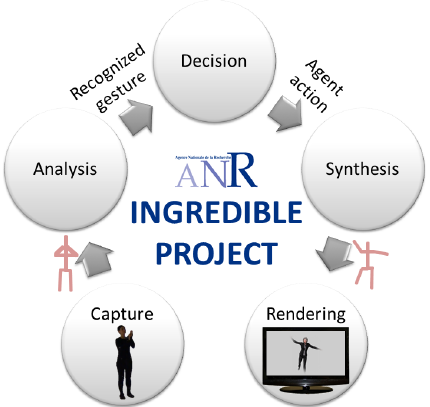
Fig. 1. Ingredible project framework. The Capture Module retrieves data from tracking devices and generates a unified 15-joints skeleton. Skeletons are being sent to the Analysis module which tries to recognize the current gesture and its expressivity. The recognition results are being sent to the Decision module which determines the agent’s response depending on the user’s behavior and the interaction scenario. The Synthesis module receives the choices obtained by the Decision module and computes the final skeleton animation displayed by the Rendering